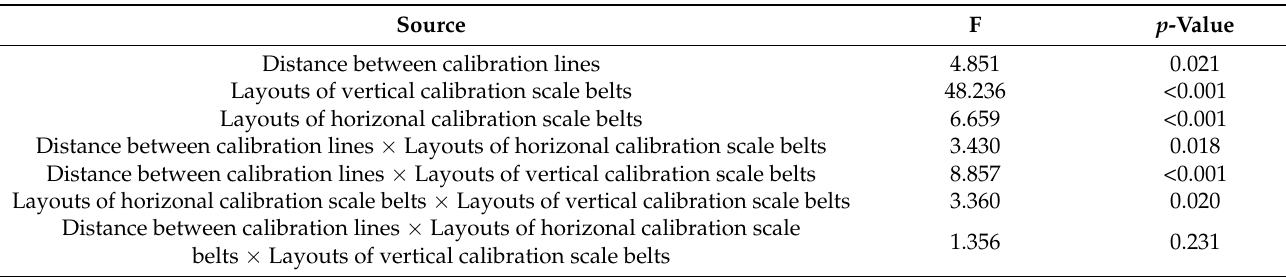
Table 4. ANOVA for task accuracy